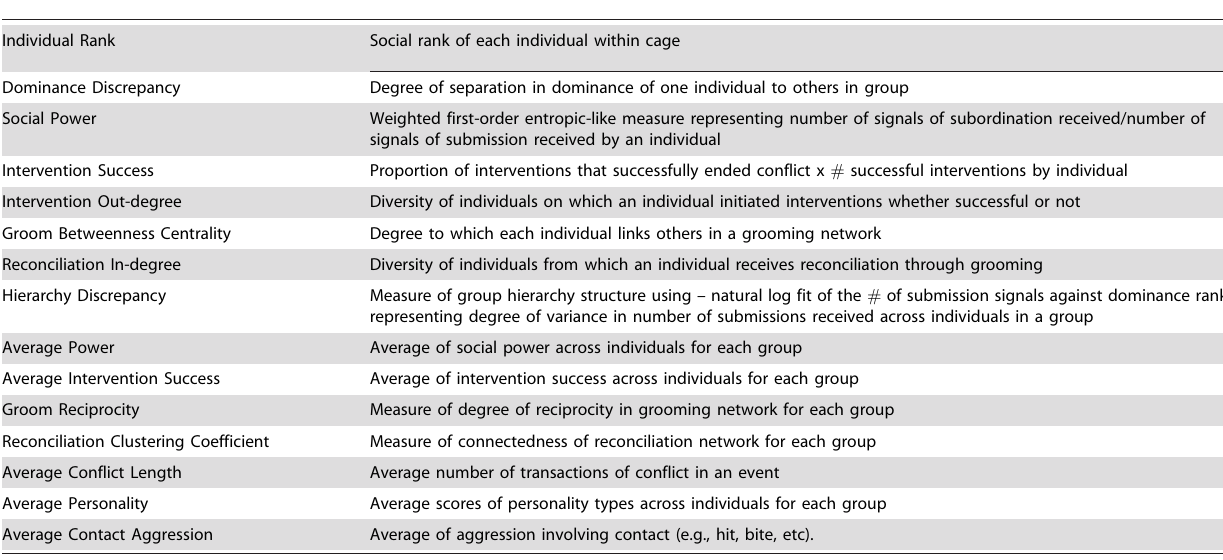
Table 2. List of measures used in